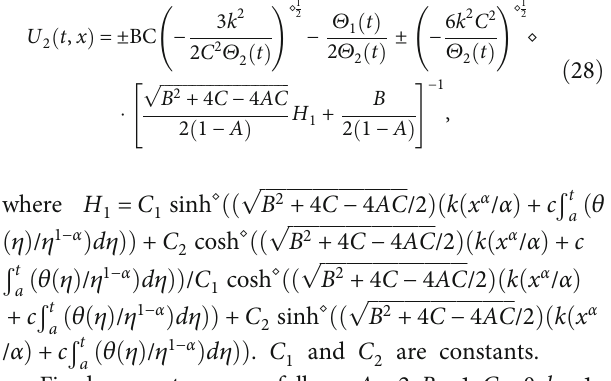
ð t Þ = 0, θ ð t Þ = − t /sin 2 0 : 5 t 1 2